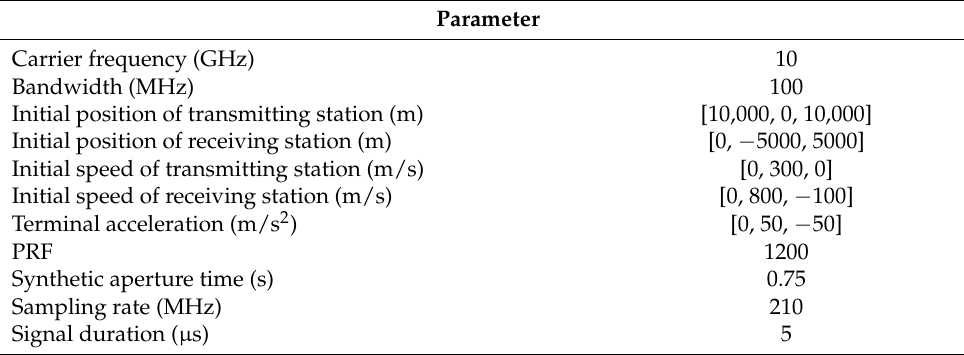
Table 3. Bistatic forward looking SAR simulation